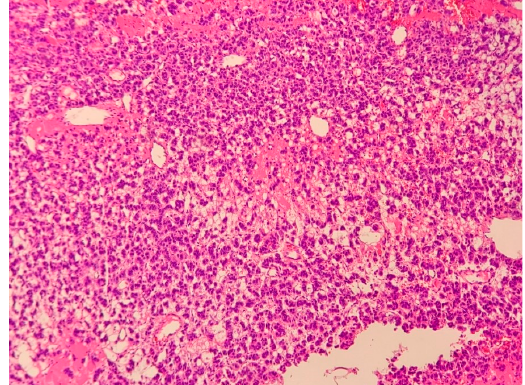
Figure 13. This adrenal tumor is composed of less than 25% of clear cells. Cells show moderate nuclear pleomorphism. A total of two blood vessels containing tumor emboli were found at the periphery of the tumor. According to the modified Weiss criteria, it suggests a malignant lesion. Hematoxylin and eosin, 40× magnification.